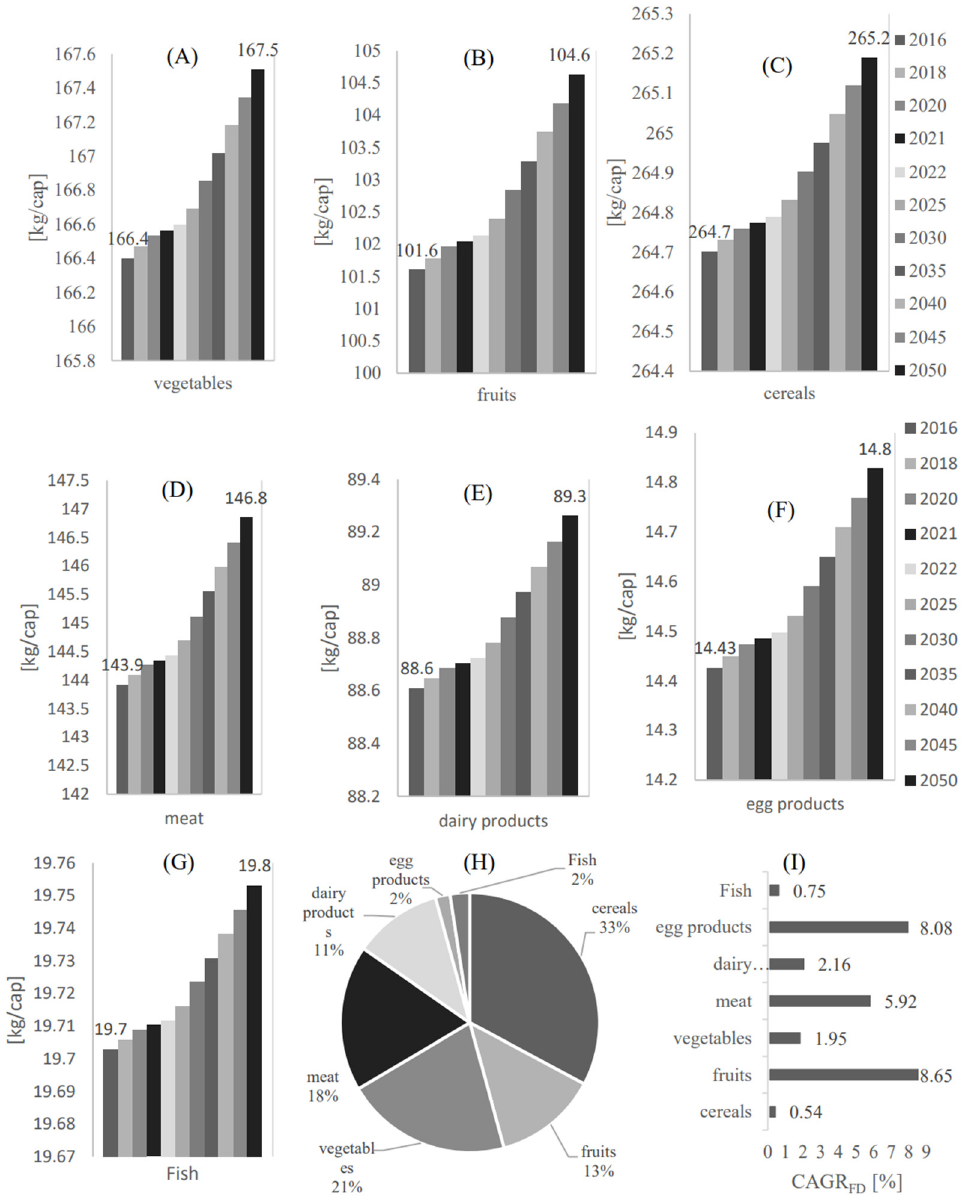
Figure 2. The food demand per capita profile from 2016 to 2050 in Qatar for ( A ) Vegetables, ( B ) Fruits, ( C ) Cereals, ( D ) Meat, ( E ) Dairy products, ( F ) Egg products, and ( G ) Fruit. ( H ) The demand percentage [Mass %] for each food category with respect to the overall food demand. ( I ) The food demand compound annual growth rate.